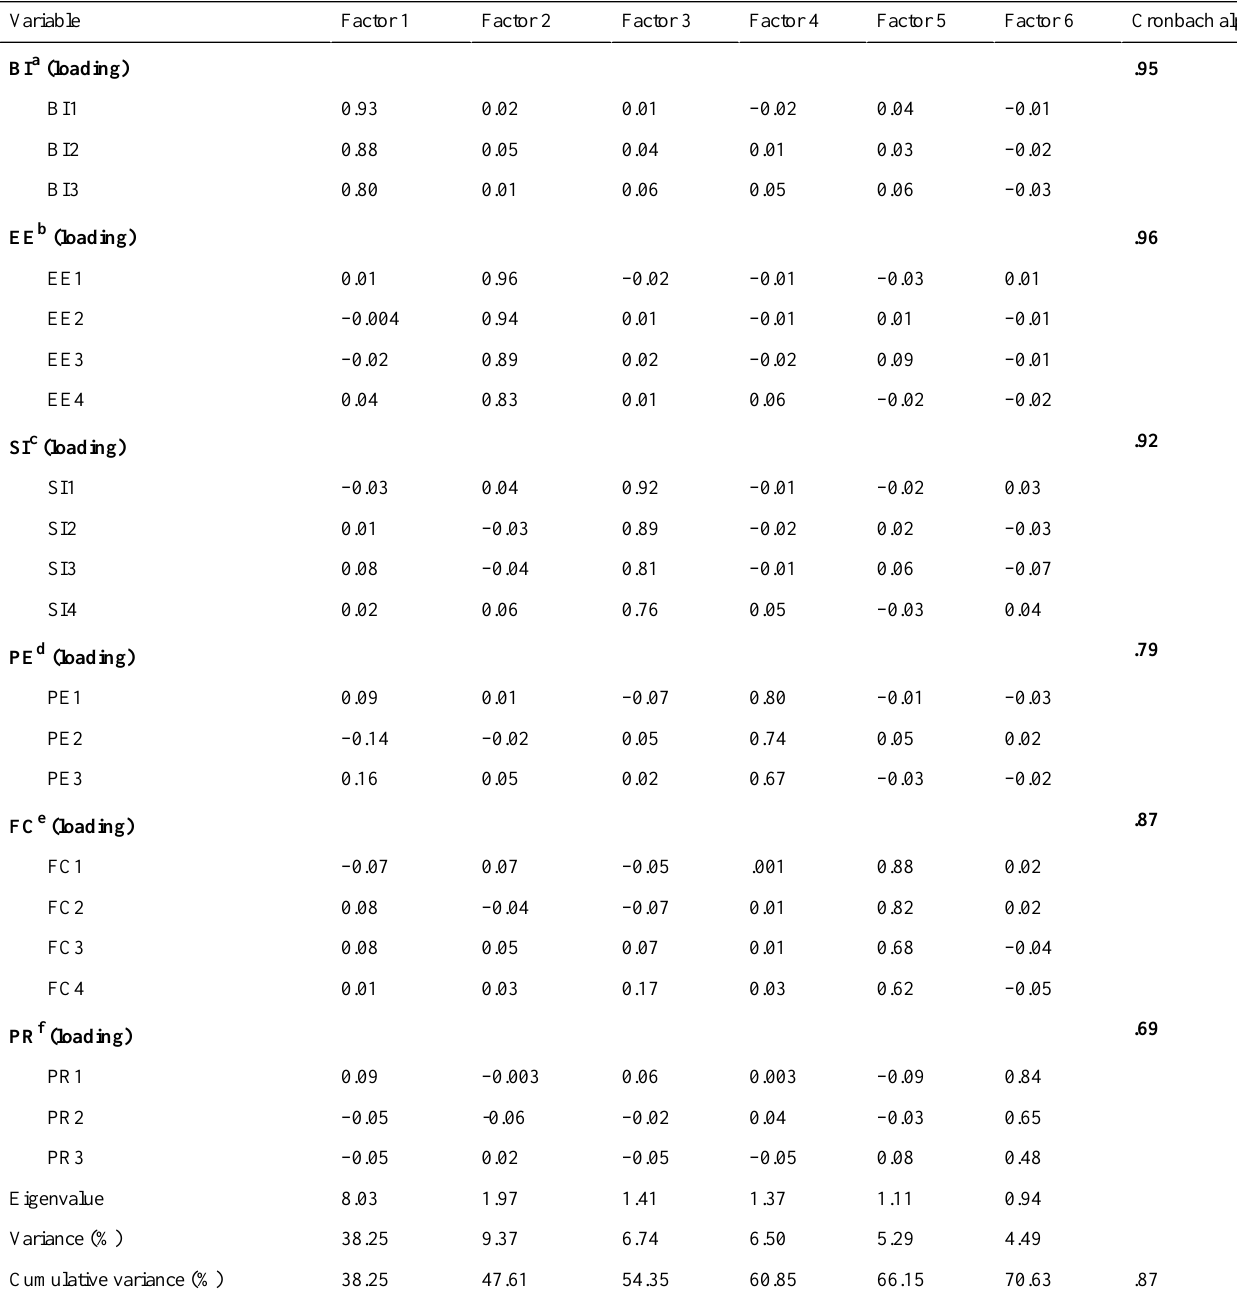
Table 4. Reliability and exploratory factor